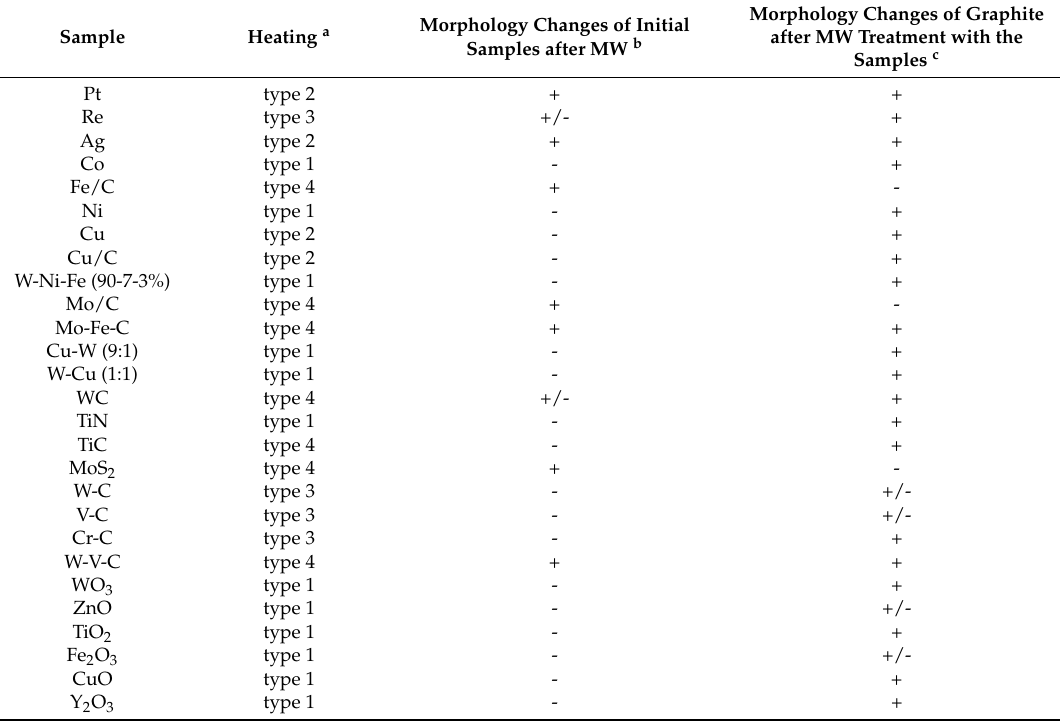
Table 1. Effect of microwave irradiation on morphology of metal-containing samples and morphology of graphite after MW-treatment in the presence of metal-containing samples. Morphology Changes of Graphite Morphology Changes of Initial after MW Treatment with the Sample Heating a Samples after MW b Samples